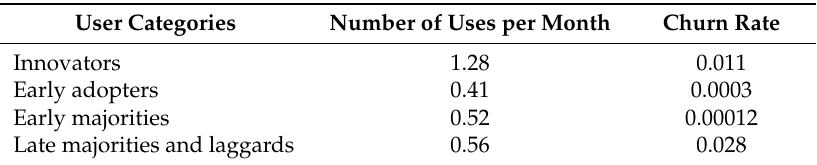
Table 2. Estimation results using Pareto /